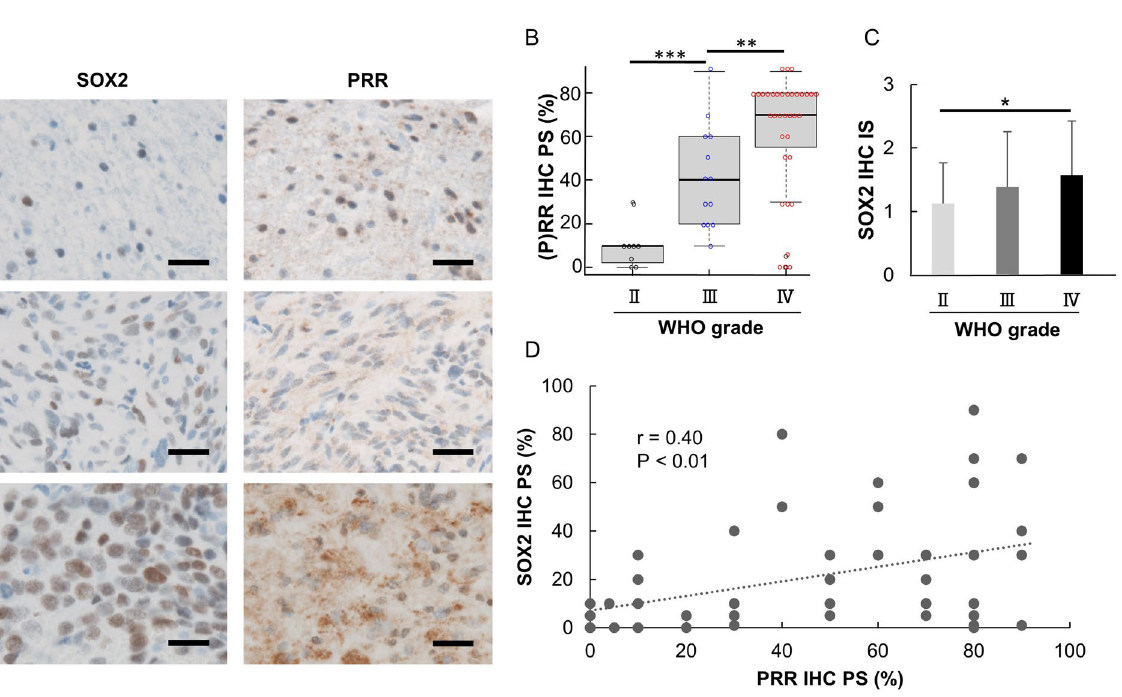
Figure 1. (P)RR and SOX2 expression in human gliomas. ( A ) Expression of SOX2 and (P)RR in representative tumor samples of each WHO grade by immunohistochemistry (scale bar = 50 µm). ( B ) PS of (P)RR and ( C ) IS of SOX2 expression increased according to the WHO grade. ( D ) SOX2 expression weakly correlated with (P)RR expression ( r = 0.40, P < 0.01). * P < 0.05; ** P < 0.01; *** P <